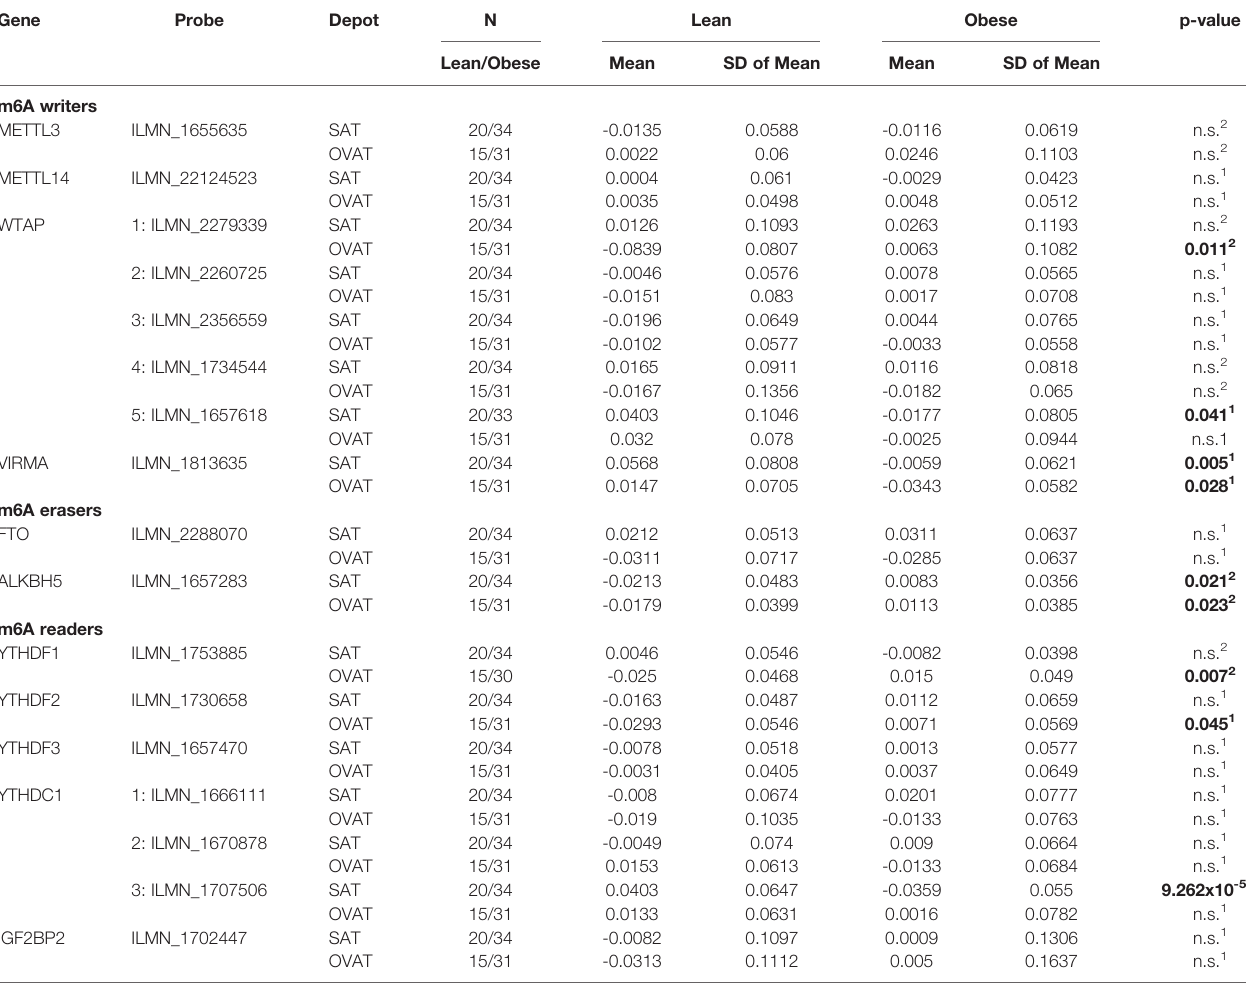
TABLE 2 | Comparison of mean gene expression of m6A regulators between lean and obese in adipose tissue. Gene Probe